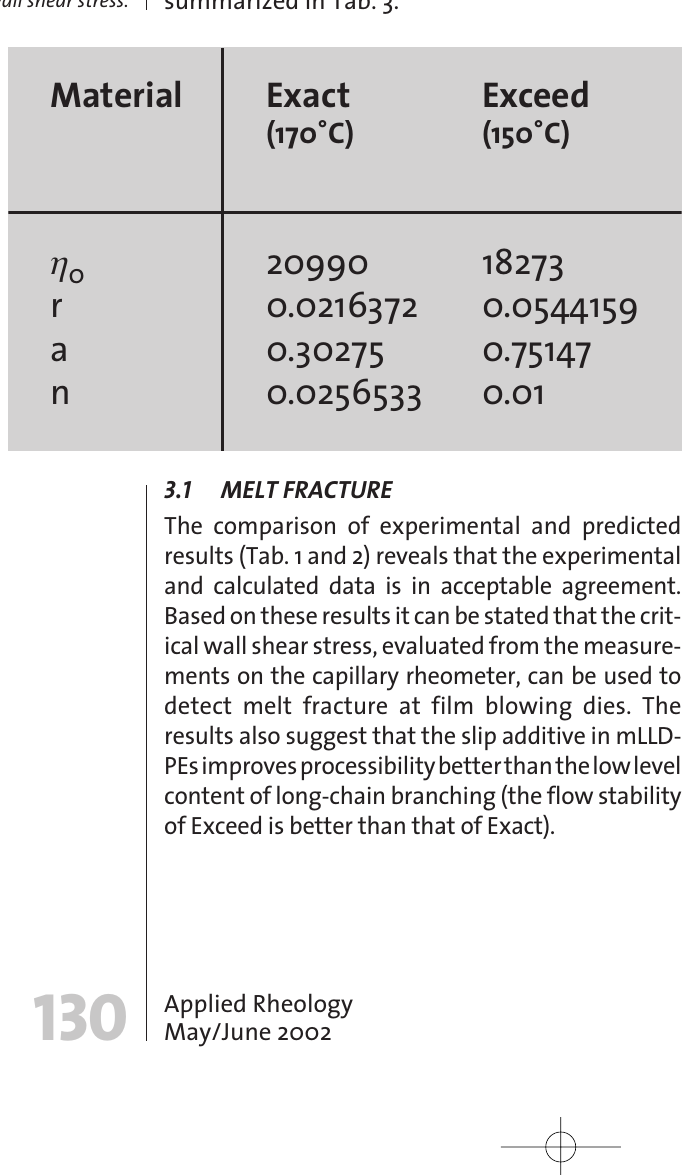
Table 3 (left): Carreau-Yasuda parameters for mLLDPE melts. Figure 8 (right): Degradation of mLLDPE Exact melt (manifested as crosslinking) in terms of increasing shear viscosity within the residence time, or the wall shear